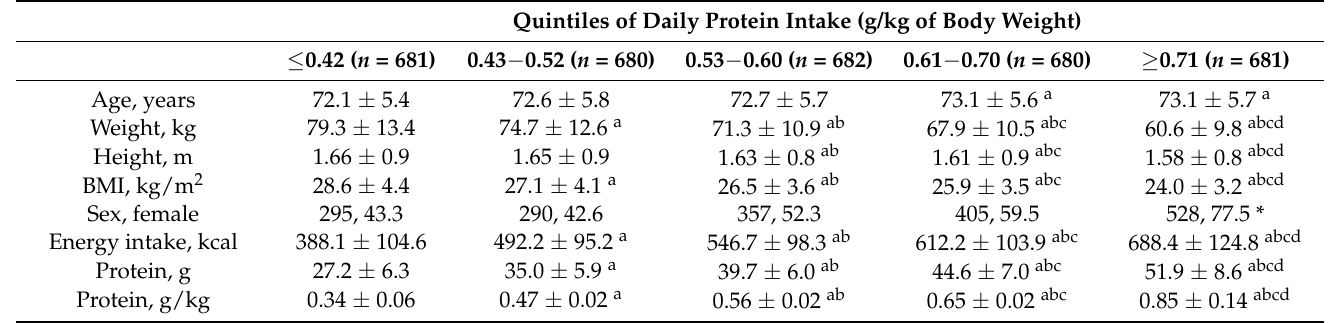
Table 1. Main characteristics of study participants according to quintiles of daily protein intake ( n = 3404). Quintiles of Daily Protein Intake (g/kg of Body